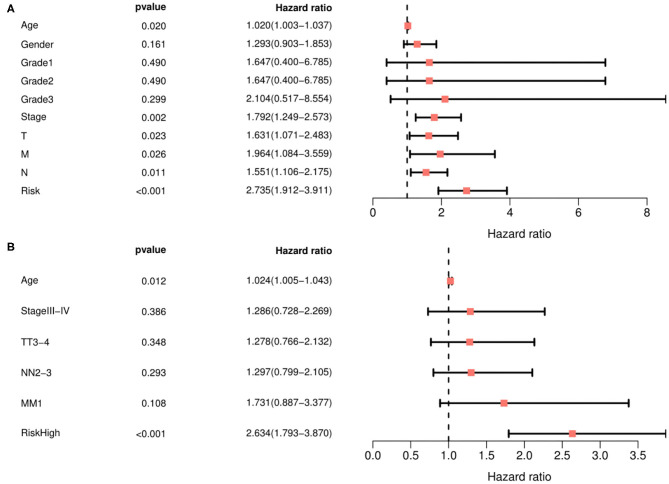
Detailed information of the specific variables involved in the final prognostic model. (A) Screening of clinical variables related to OS by univariate analysis in the GC cohort. (B) Identification of the final variables by multivariate analysis based on the backward stepwise variable selection with the Akaike information criterion (AIC). P < 0.05 indicates statistical significance.